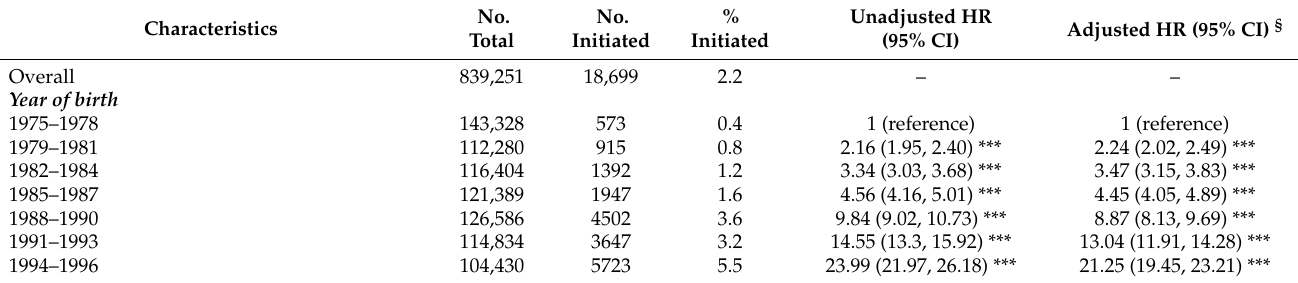
Table 1. Sociodemographic characteristics of HPV vaccination initiation among women eligible for opportunistic HPV vaccination in